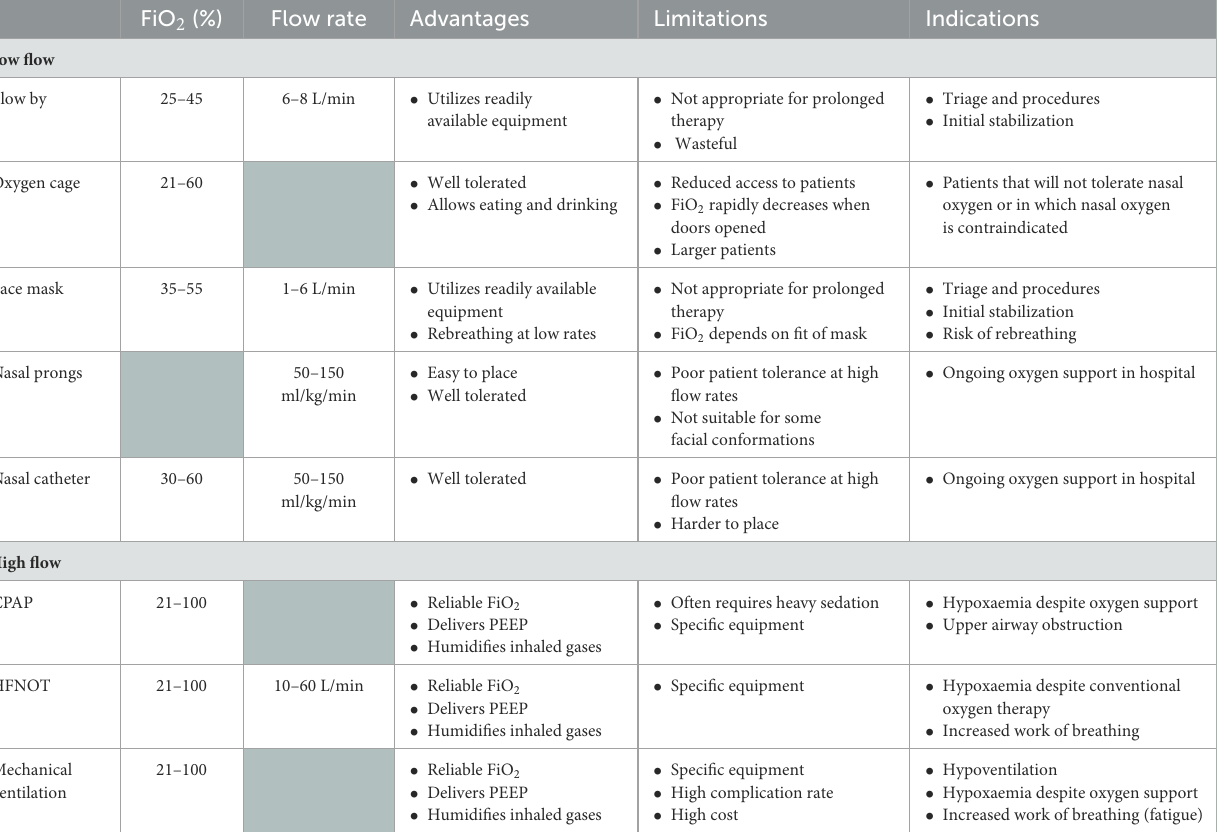
TABLE 1 Modes of oxygen supplementation in veterinary patients. Advantages